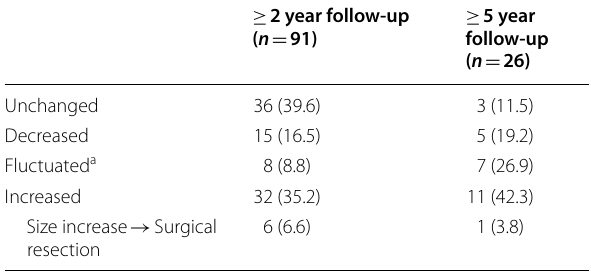
Data are percentages in parentheses a Fluctuated refers to lesions that change in size in both directions (decreased and increased or increased and decreased) during follow-up